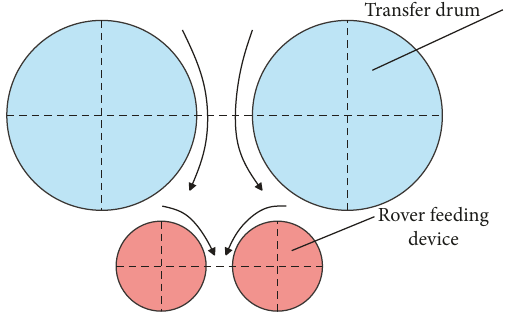
Figure 2: Schematic diagram of the transmission